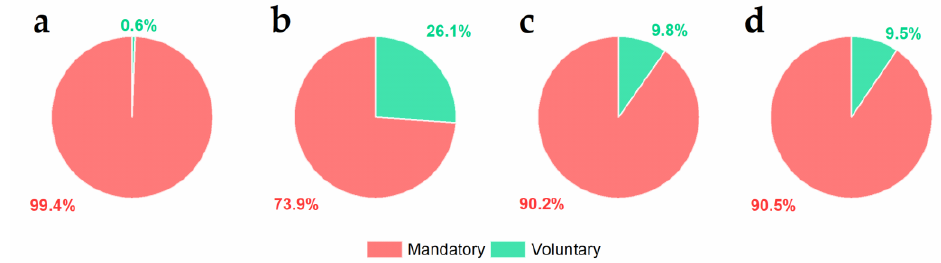
Figure 2. Share of individual answers to the surveyed groups on the Declaration of Performance: ( a ) investors, ( b ) architects, ( c ) contractors, ( d ) sellers of construction products.